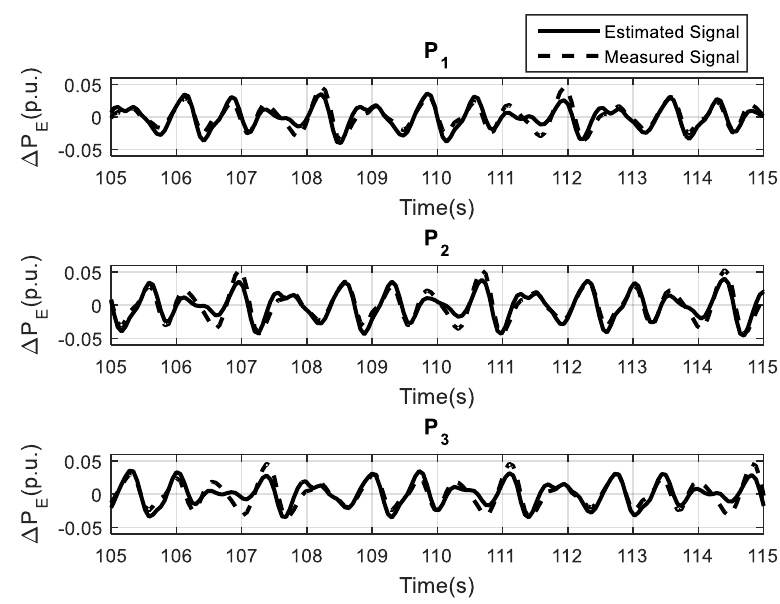
Figure 6. Measured (dashed line) and the estimated (continuous line) active power deviation response.